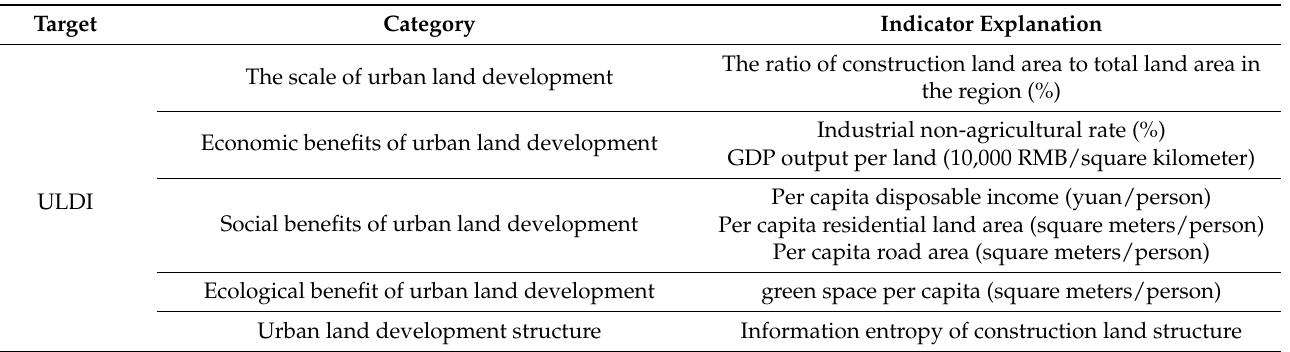
Table 2. ULDI evaluation index